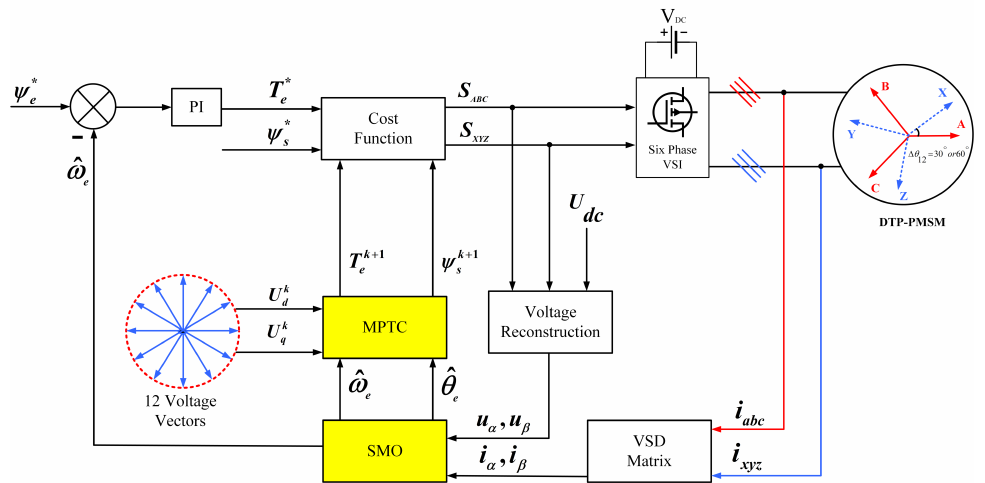
Figure 9. Model predictive torque control system